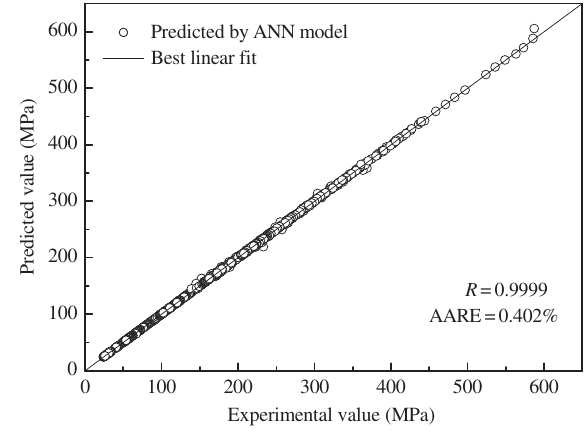
Figure 9 Correlation between experimental and predicted flow stress for the training datasets